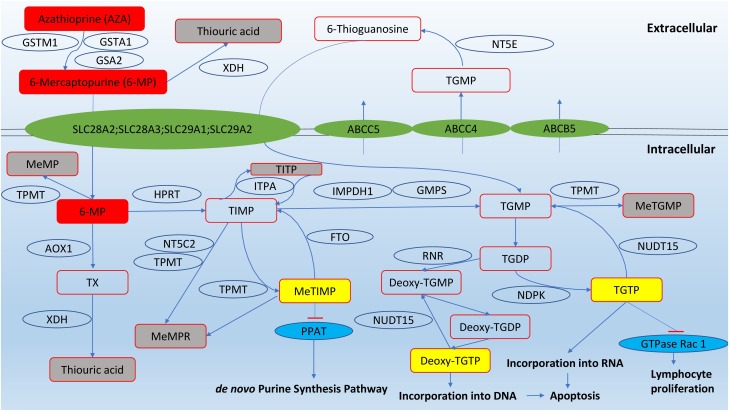
Pathways of thiopurine disposition and action (adapted from Zaza et al., 2010). Cytosolic 5′-nucleotidase II (NT5C2); ecto-5′-nucleotidase (NT5E); fat mass and obesity-associated protein (FTO); nudix hydrolase 15 (NUDT15); glutathione S-transferase mu 1 (GSTM1); glutathione S-transferase alpha 1 (GSTA1); Glutathione S-transferase alpha 2 (GSTA2); thiopurine methyltransferase (TPMT); xanthine dehydrogenase (XDH); hypoxanthine guanine phosphoribosyltransferase (HPRT); inosine triphosphate pyrophosphatase (ITPA); inosine monophosphate dehydrogenase type 1 (IMPDH1); guanosine monophosphate synthetase (GMPS); aldehyde oxidase type 1 (AOX1); phosphoribosyl pyrophosphate amidotransferase (PPAT); ribonucleotide reductase (RNR); nucleotide diphosphate kinase (NDPK); methyl-mercaptopurine (meMP); thioxanthine (TX); methyl-mercaptopurine ribonucleotides (meMPR); thioinosine monophosphate (TIMP); thioinosine triphosphoate (TITP); methyl-thioinosine monophosphate (meTIMP); thioguanine monophosphate (TGMP); methyl-thioguanine monophosphate (meTGMP); thioguanine diphosphate (TGDP); thioguanine triphosphate (TGTP).